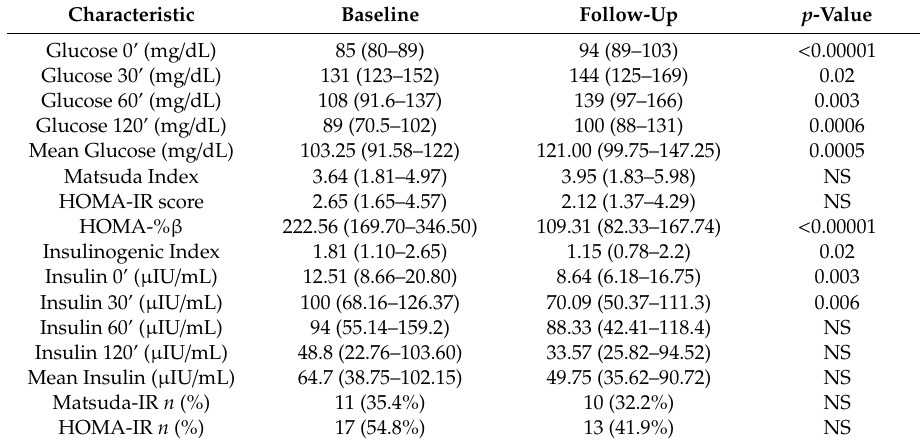
Table 4. Di ff erences in glucose metabolism variables between baseline and follow-up investigations ( n =